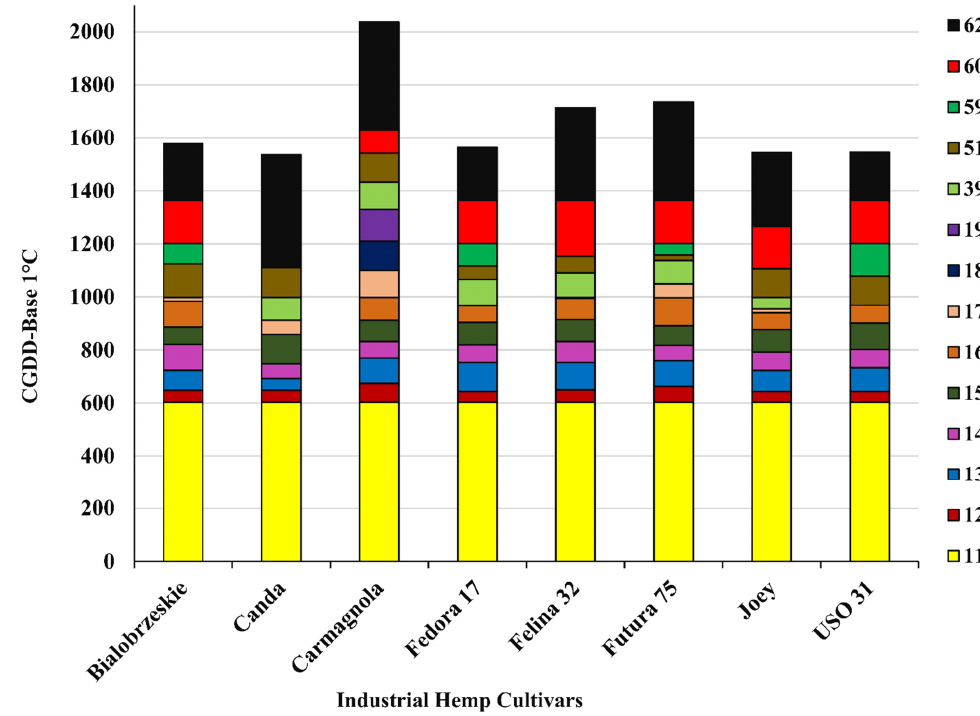
Figure 2. Industrial hemp (Grain, Fiber, and Dual types) and the relation of Cumulative Growing Degree Days (Base Temp 1 °C—[14]) with growth stages based on BBCH Code 11 (First leaf pair); 12 (Second leaf pair); 13 (Third leaf pair); 14 (Forth